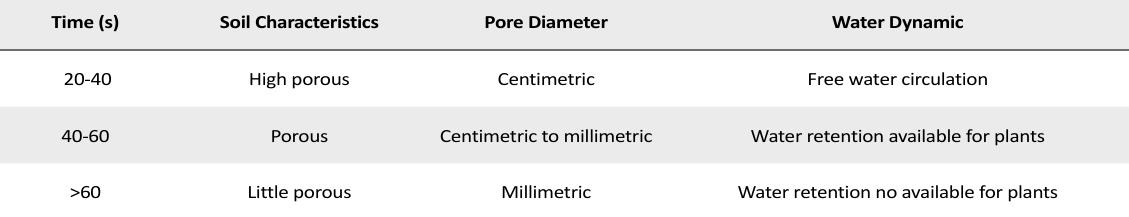
Table 3. Porosity characteristics